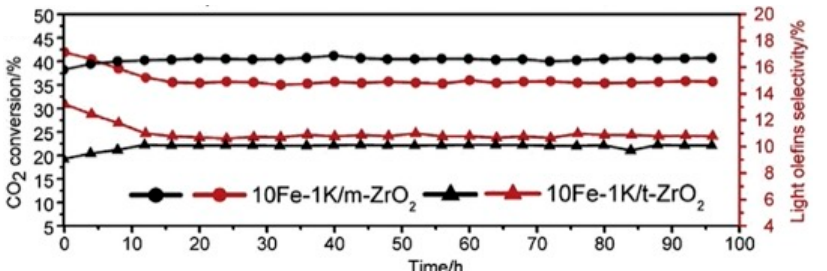
Figure 14. The stability of 10Fe1K/m-ZrO 2 and 10Fe1K/t-ZrO 2 for CO 2 conversion, and the light olefin selectivity at a TOS of 100 h at 613K. Adapted with permission from ref. [114]. Copyright 2019 Elsevier.